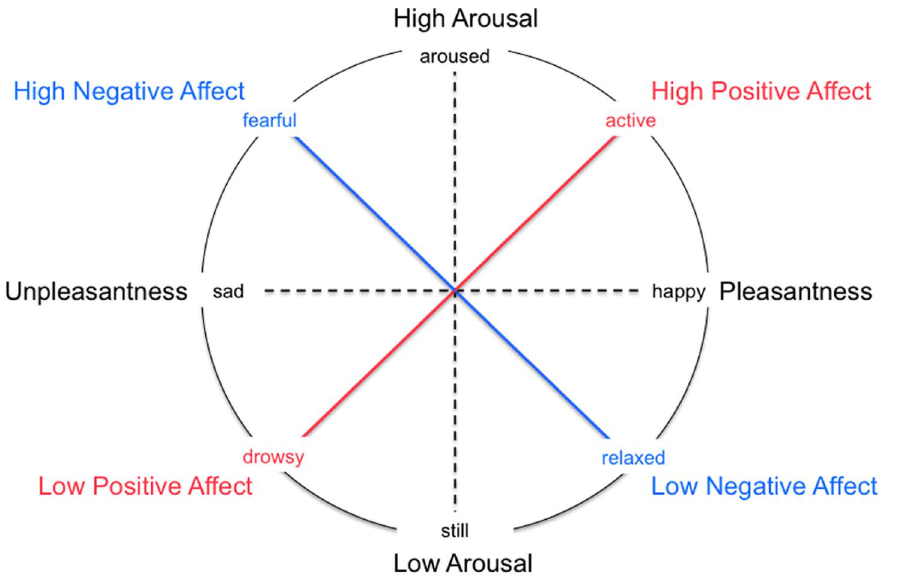
Figure 2. The PANAS captures two independent dimensions of Positive Affect (PA) and Negative Affect (NA). (Figure based on [32]). In this circumplex model of affective space, they fall between the Pleasantness and Arousal spectra, two dimensions which are orthogonal themselves. The PANAS scales emerge after rotation of these two factors. The correlation between the PA and NA scales is low enough to suggest relative independence when taking the measurement error into